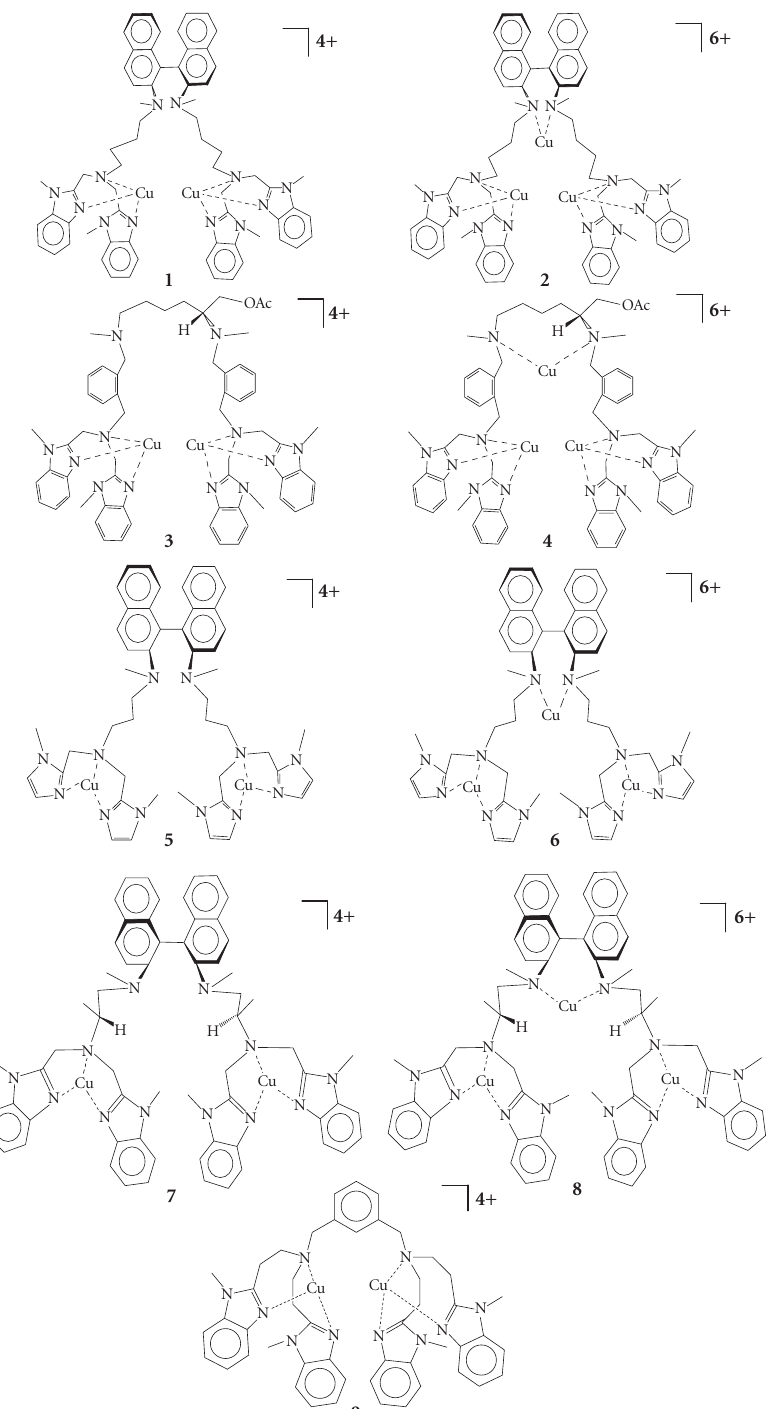
to give the corresponding o-quinones. To confirm this behavior, new chiral catechols were employed in these catalytic stereoselective oxidations. D -(+)-catechin